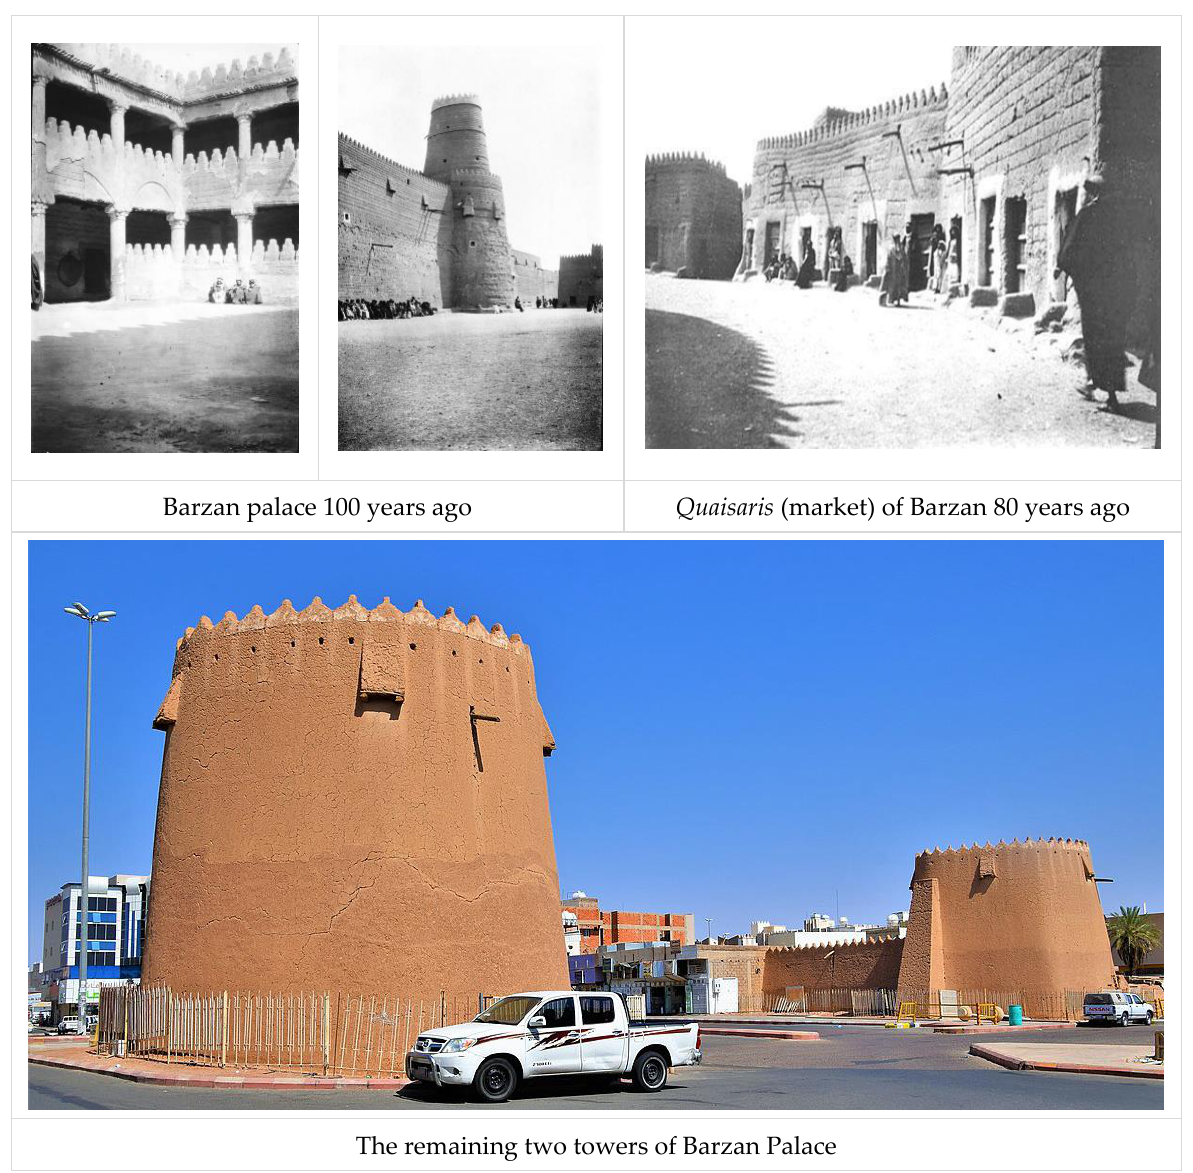
Figure 5. Historical images of Hail City. Source: [80] and Authors.